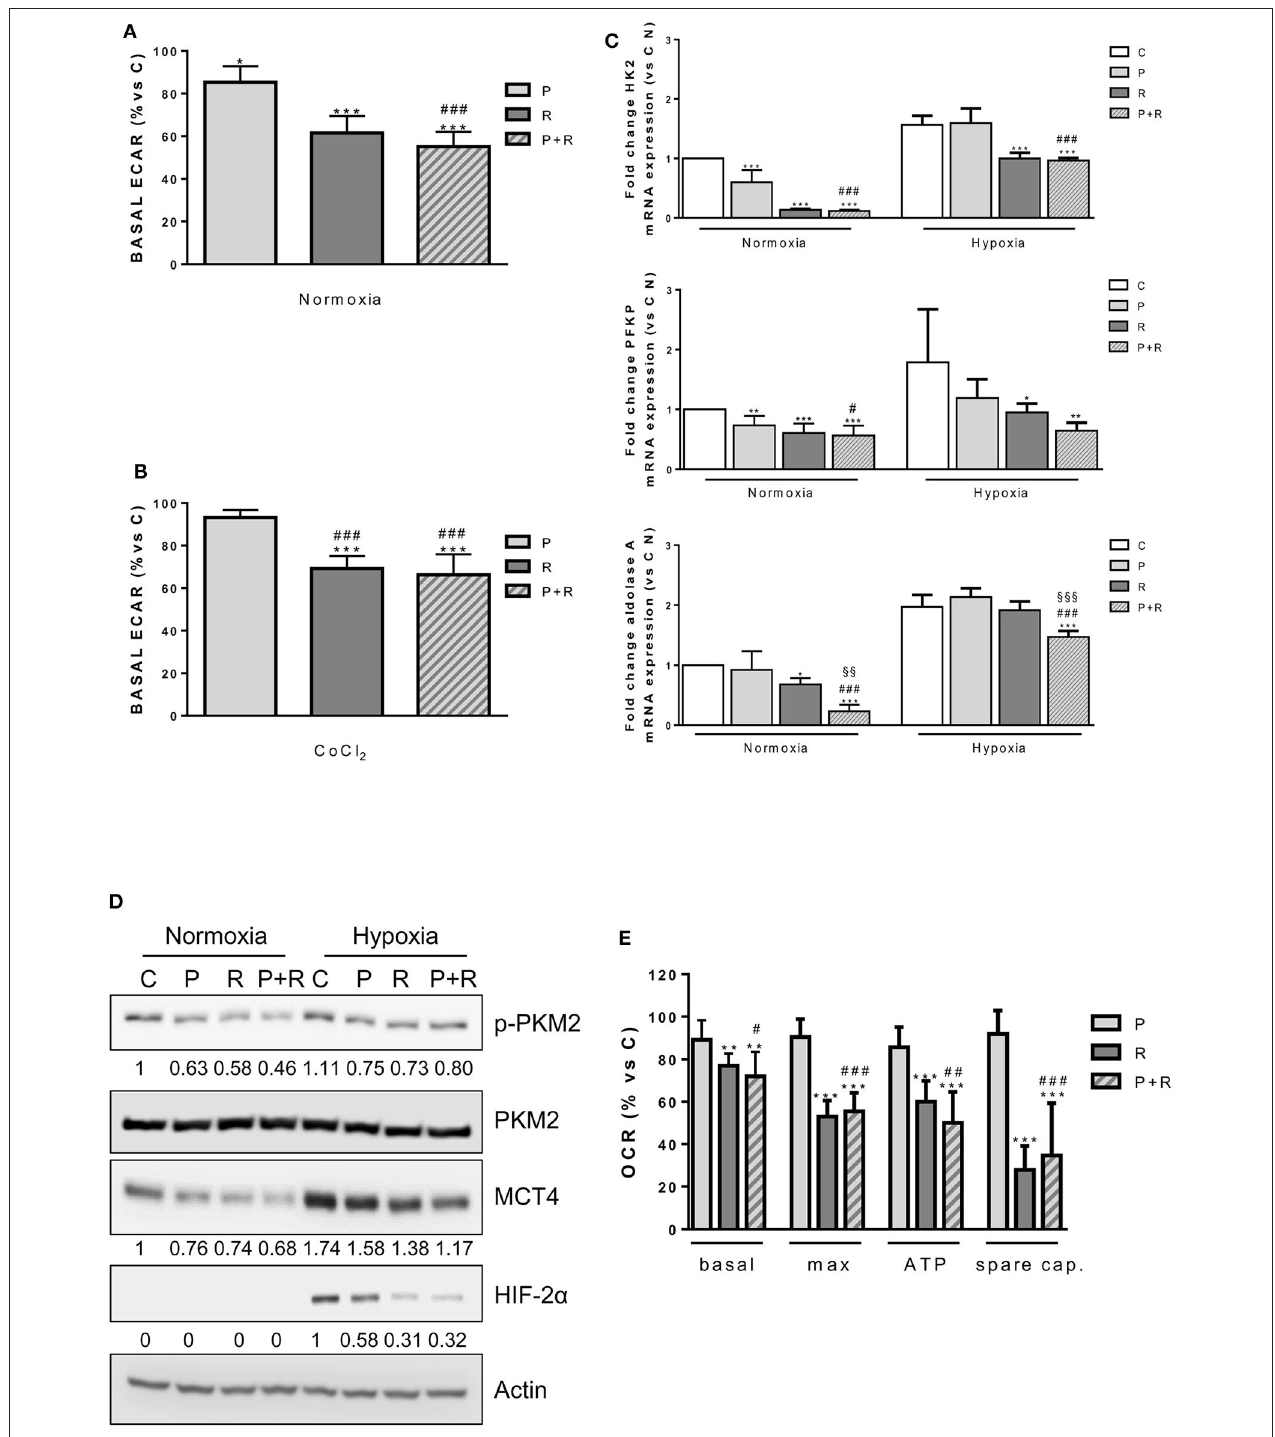
FIGURE 7 | (A) HepG2 cells were treated with 1 µ M P or 1 µ M R alone or in combination for 24h. Then, basal ECAR was measured by seahorse. (B) HepG2 cells were treated with 1 µ M P or 1 µ M R alone or in combination in the presence of 200 µ M CoCl 2 for 24h. Then, basal ECAR was measured by seahorse. (C) HepG2 cells were treated as in panel (A) under normoxic and hypoxic conditions for 24h. After cell lysis, HK2, PFKP, and aldolase A mRNA expression levels were analyzed by RT-PCR. Results are plotted as 2 − 11 CT ± SD. (D) HepG2 cells were treated as in panel (A) under normoxic and hypoxic conditions, were lysed and the expression of the indicated proteins was evaluated by Western blot analysis. (E) HepG2 cells were treated as in panel (A) and analyzed for the mitochondrial function through the seahorse mitochondrial stress test. Data are mean values ± SD of two (E) or three (A–C) independent experiments. * p < 0.05, ** p < 0.01, *** p < 0.001 vs. C; # p < 0.05, ## p < 0.01, ## p < 0.001 vs. P; §§ p < 0.01, §§§ p < 0.001 vs. R. Results in panel (D) are representative of three independent experiments.